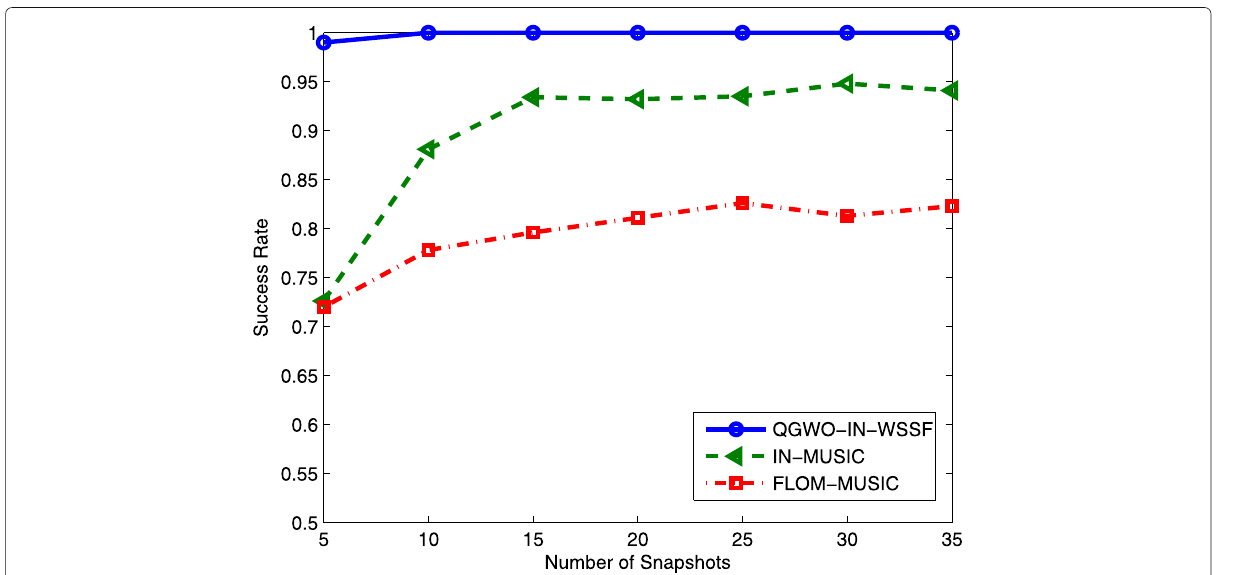
Fig. 2 Success rate curves versus the number of snapshots for two independent sources with GSNR = 20dB and α = 1.5